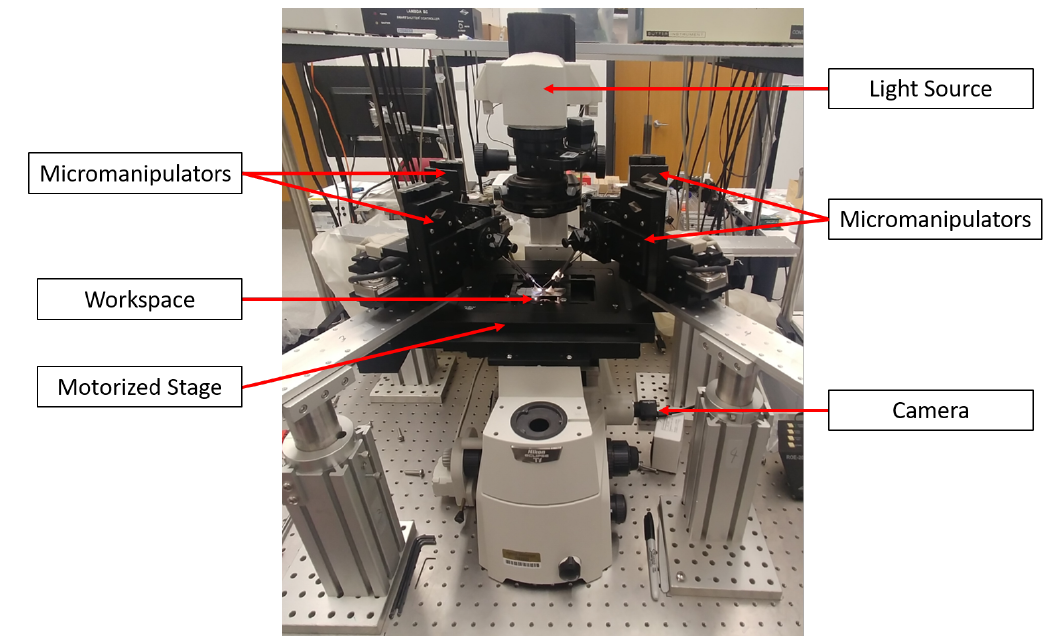
Figure 1. The vision-based micro-force sensing micromanipulation system ( µ VBFS-MS). Up to four micromanipulators can be mounted around the inverted optical microscope system with a integrated motorized XY stage. Custom end-effectors for the micromanipulators allow for 3D vision-based micro-force sensing in conjunction with tracking algorithms operating on real-time images captured with the camera system.